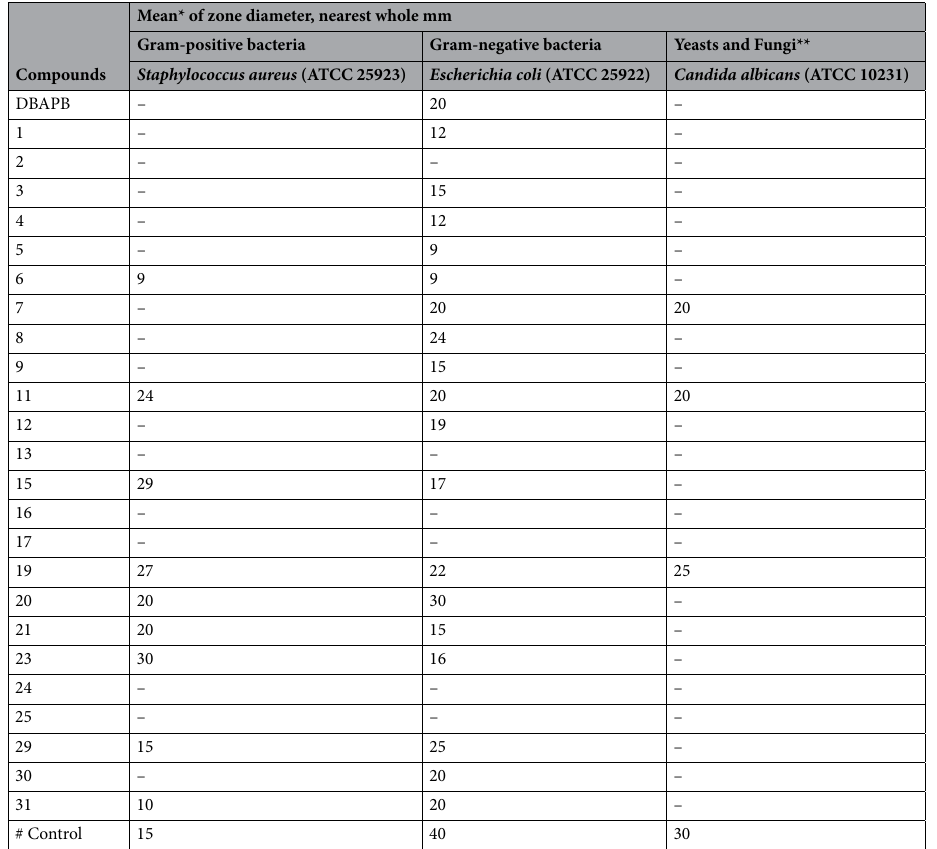
Table 8. In vitro antimicrobial evaluation of the ligand, DBAPB, and its metal complexes. *Calculate from 3 values. **Identified based on routine cultural, morphological and microscopical characteristics. – = No effect. # Cefoxitin in the case of Gram-positive bacteria, chloramphenicol in the case of Gram-negative bacteria and fluconazole in the case of